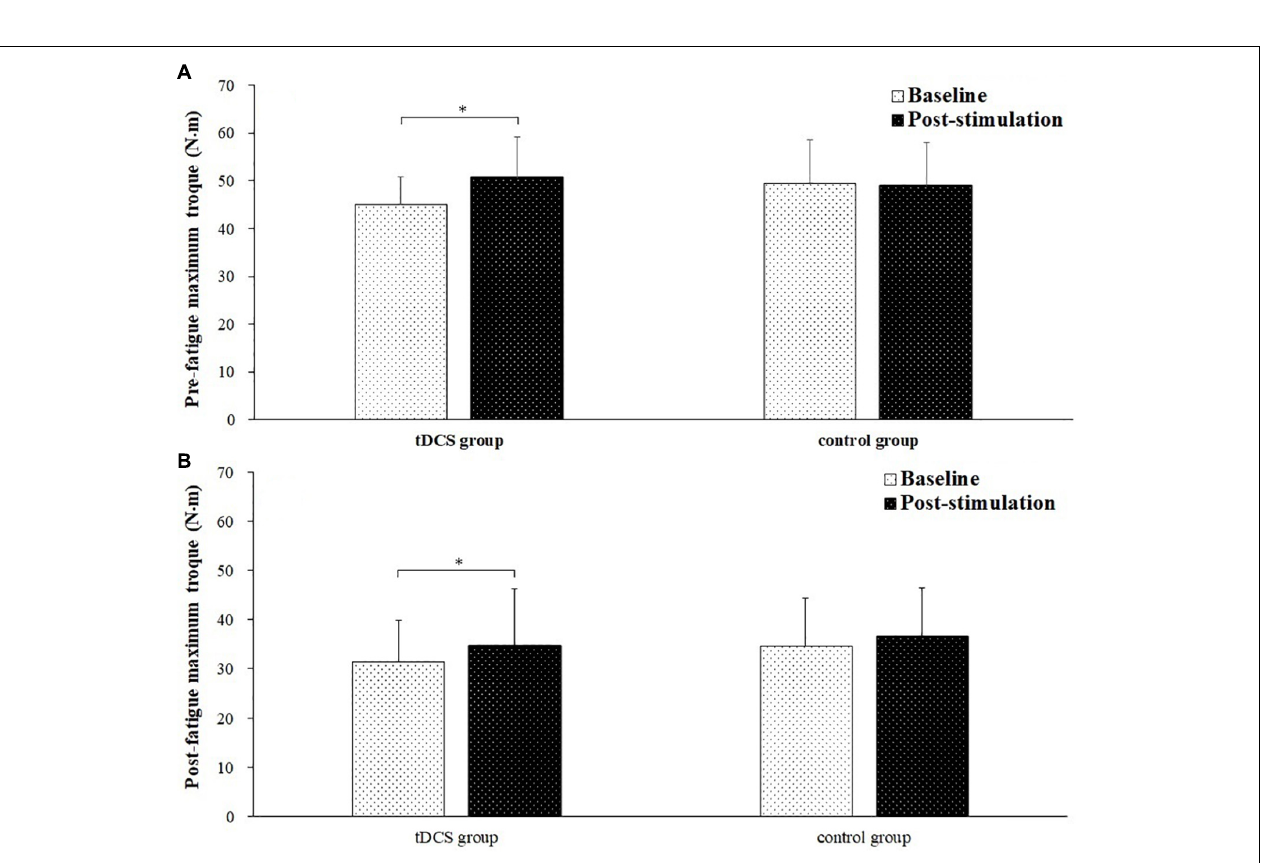
FIGURE 4 | Pre- and post-fatigue maximal torque (mean ± SD) of elbow flexion tested during baseline and post-stimulation for transcranial direct current stimulation (tDCS) group and control group subjects. *demonstrated a significant difference of observed index between the baseline and post-stimulation test.